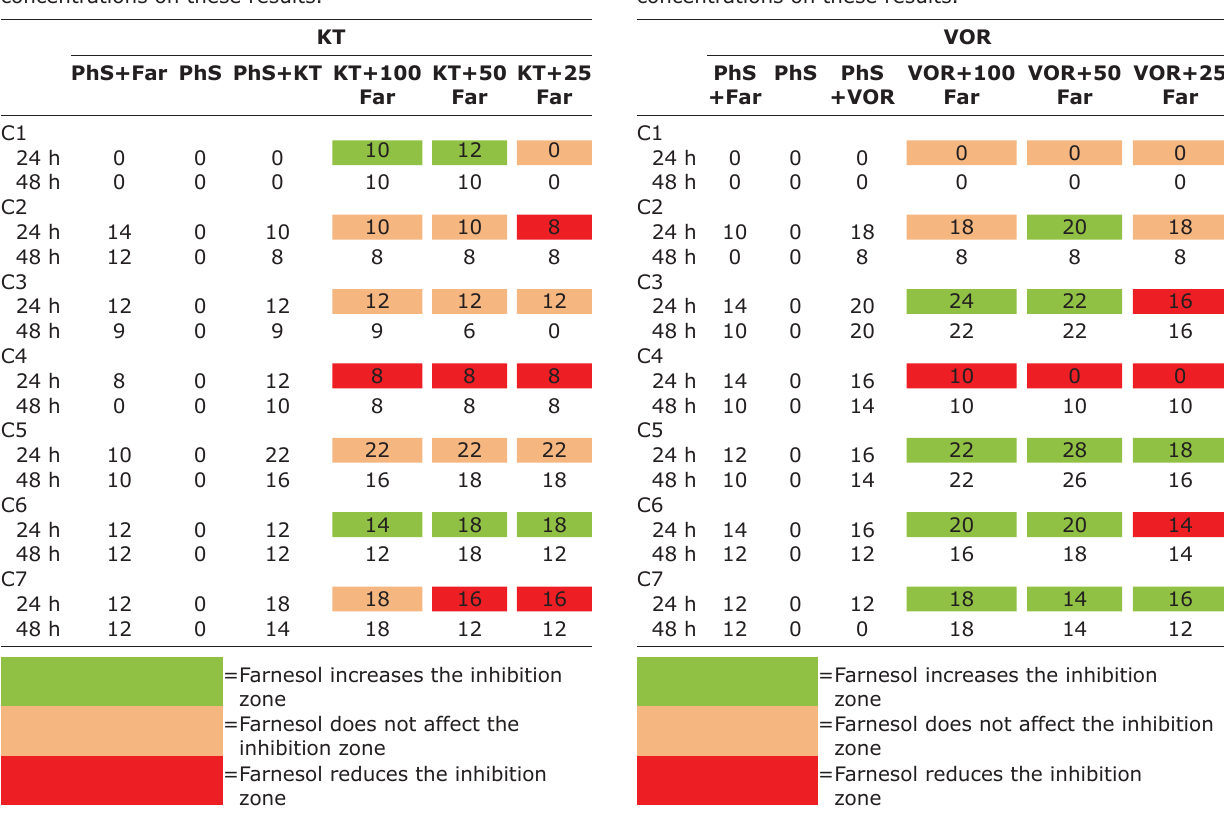
Table-3: Ketoconazole sensitivity determination of 7 Candida albicans strains and the effect of farnesol three concentrations on these results.